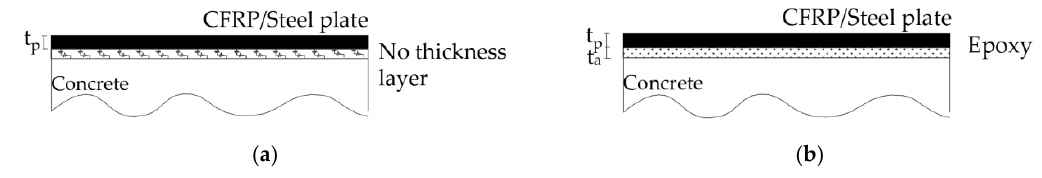
Figure 2. Modeling of adhesive layer with: ( a ) non-linear springs; ( b ) real epoxy layer.